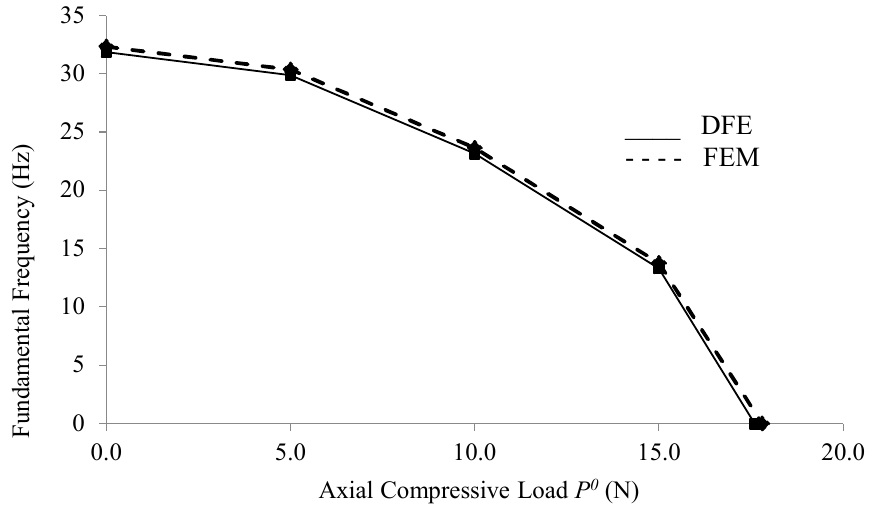
Figure 4. Variation of the fundamental natural frequency vs. axial compressive force for M zz = 20 N.m, obtained from the five-element FEM and DFE models.